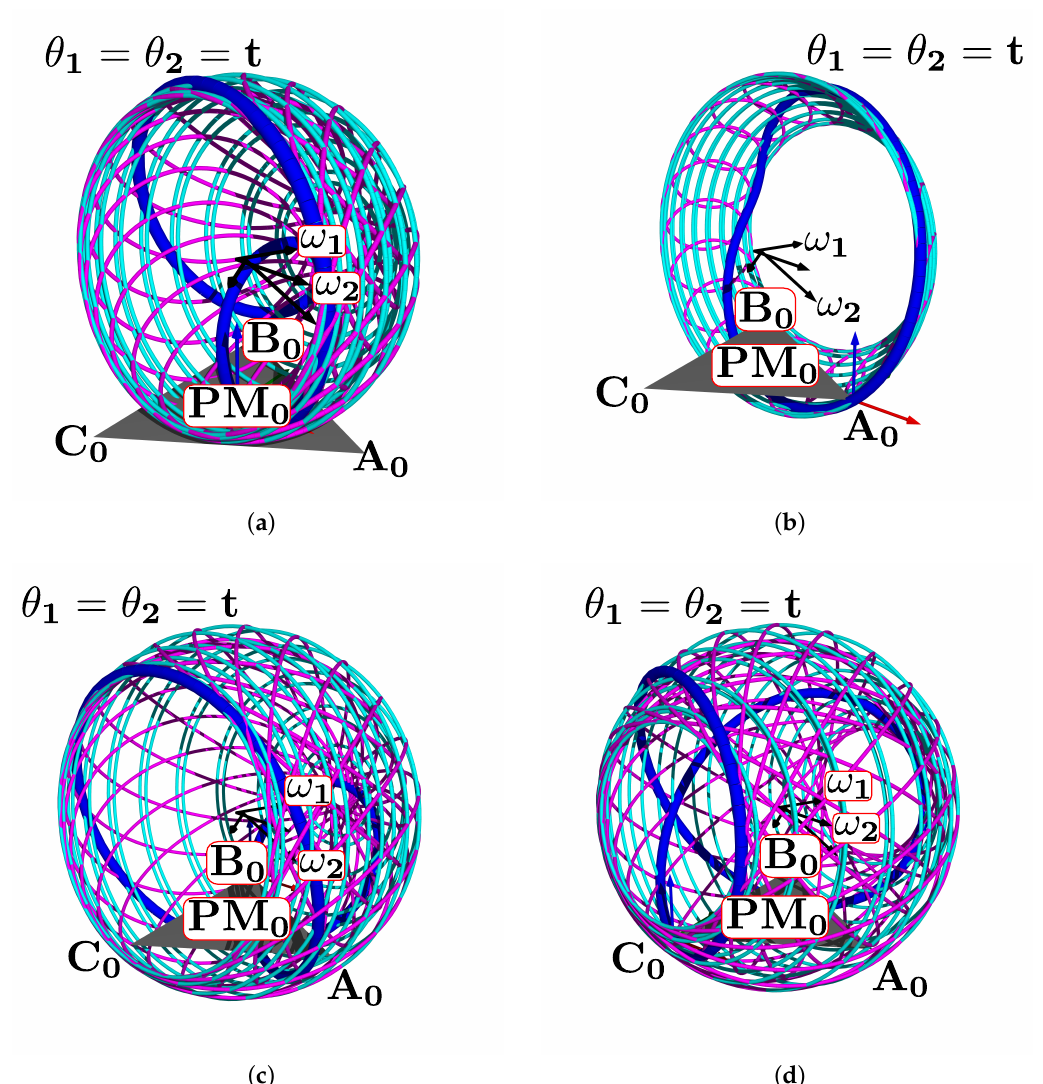
Figure 24. Simulation of all points: ( a ) platform’s central point, ( b ) attachment a, ( c ) attachment b, and ( d ) attachment